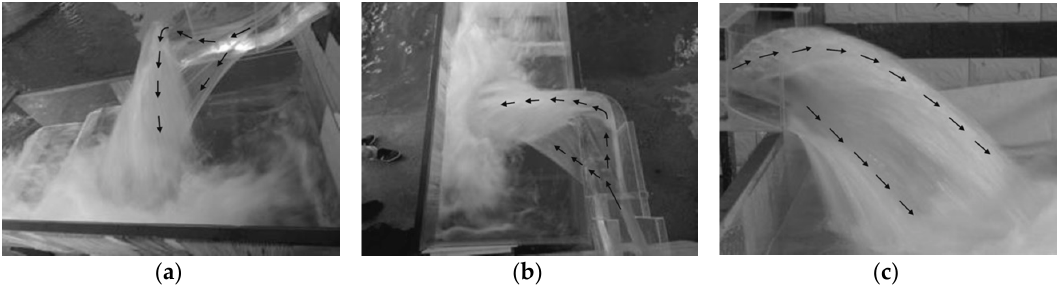
Figure 2. Typical pattern of the streamwise-lateral discharge spillway: ( a ) physical model from the downstream view; ( b ) physical model from the lateral view; ( c ) ski-jump flow.